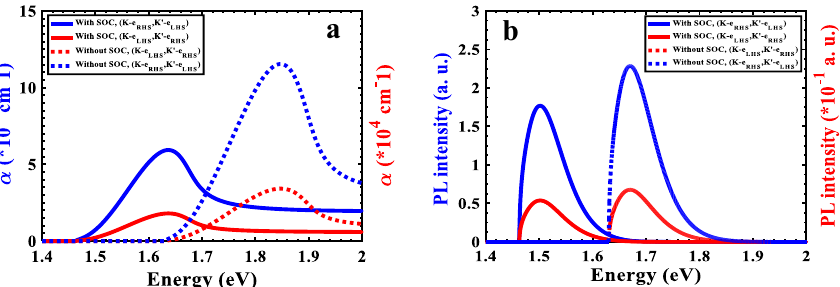
Figure 5. The behavior of ( a ) absorption coefficient ( b ) and photoluminescence intensity for different valleys and polarizations in both cases of with and without